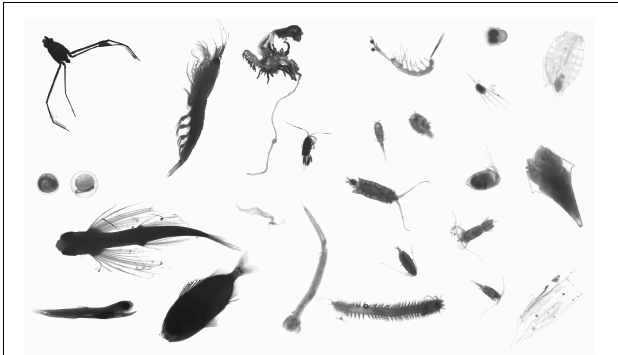
FIGURE 8 | Zooscan vignettes of organisms from HSN tows, including fish, fish eggs, insect, crustaceans, larvacean, chaetognath, siphonophore, salp, mollusc, worm, echinoderm larvae and